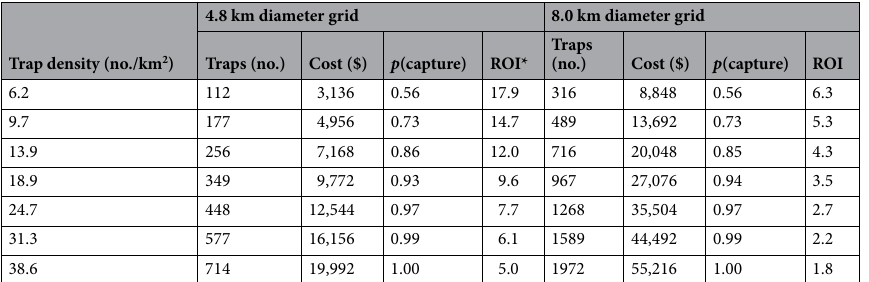
Table 2. Comparison of circular grids with diameters of either 4.8 km or 8.0 km for leek moth with highly attractive traps (1/λ = 20 m), showing numbers of traps, costs and return on investment (ROI), and the likelihood of capture ( p (capture)). * ROI: return on investment, capture percentage for each $1,000 spent.